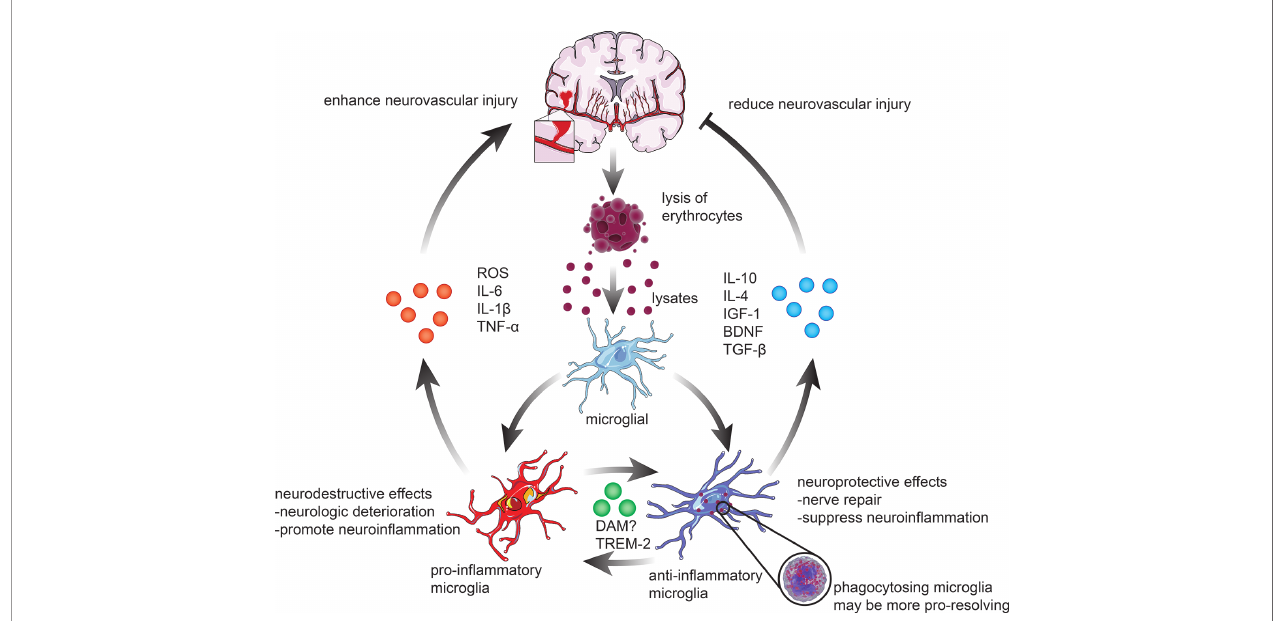
FIGURE 2 | Microglial activation and polarization following ICH. The polarization of microglia in response to stimulation with erythrocyte lysates after ICH can be broadly classi fi ed into two categories. 1) pro-in fl ammatory microglia elevate the levels of ROS, interleukin-6 (IL-6), interleukin-1 b (IL-1 b ), and tumor necrosis factor- a (TNF- a ), hence enhancing the pro-in fl ammatory and destructive effects of ICH on the brain. 2) anti-in fl ammatory microglia, on the contrary, mainly exert neuroprotective effects, including actions related to nerve repair and anti-in fl ammatory effects, through phagocytosis of lysates, which are always associated with higher expression of IL-10, IL-4, insulin-like growth factor-1 (IGF-1), brain-derived neurotrophic factor (BDNF), and transforming growth factor- b (TGF- b ). In recent years, an increasing number of studies have revealed that microglia can also be polarized into neuroprotective and neurodestructive phenotypes, such as disease- associated microglia (DAM) and triggering receptor expressed on myeloid cells 2 (TREM2) phenotypes, which remain to be further investigated.